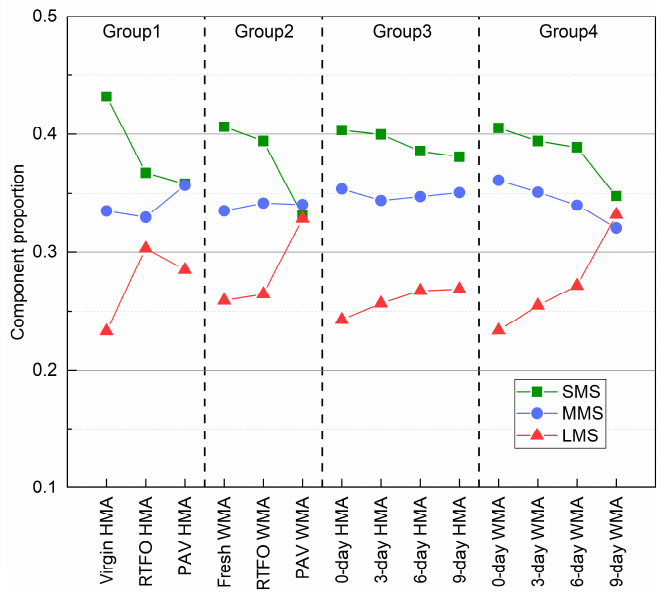
Figure 10. Components proportion (SMS, MMS, and LMS) of the binder before and after ageing according to the GPC curve.